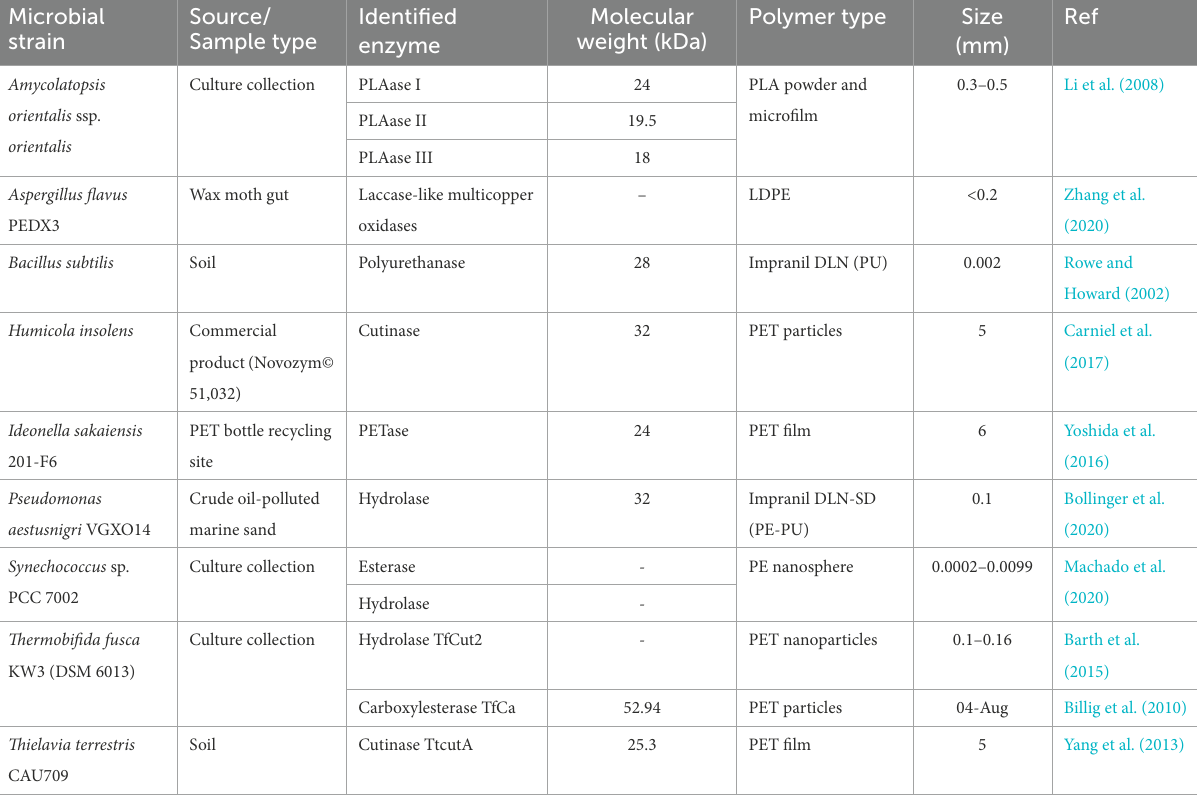
TABLE 1 List of some reported plastic-degrading enzymes from various microbial strains against various polymer types. Microbial